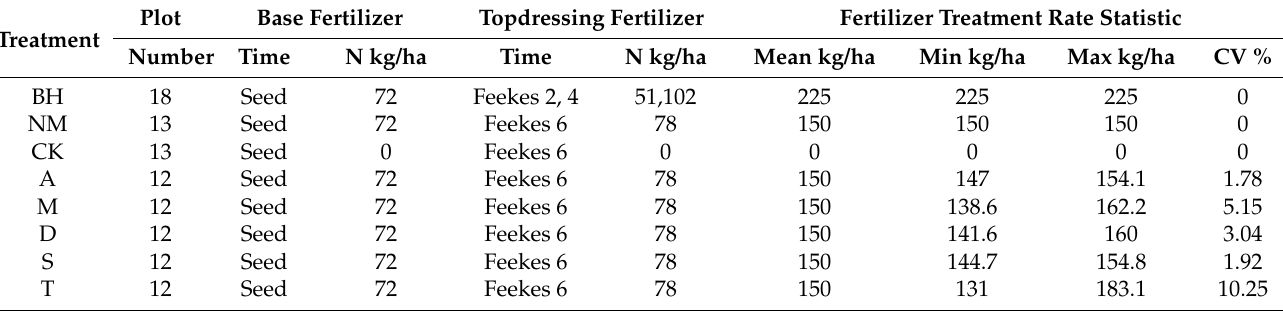
Table 1. Fertilizer information for different treatments.